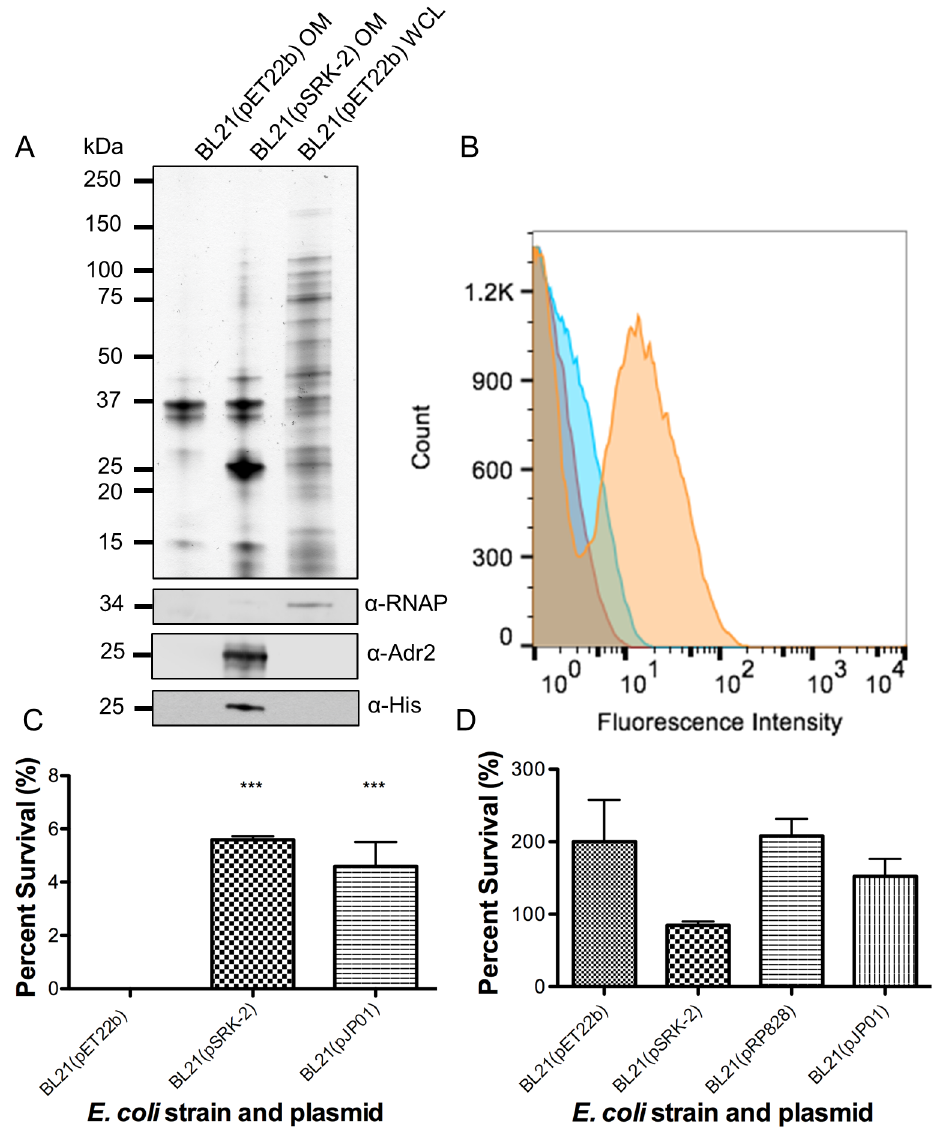
Fig 3. Expression of Adr2 at the E . coli outer-membrane is sufficient to mediate resistanceto serum- killing. (A) OM preparations or WCL from E . coli transformed with the empty vector (pET22b) or the plasmid encoding for R . conorii His 6 -tagged Adr2 are separatedby SDS-PAGE. Subsequentsilver staining demonstrates similar protein loadingand migration. Anti- E . coli RNA Polymerase alpha (RNAP) is used to demonstrate the presence of cytoplasmic contents. (B) Flow cytometry analysisrevealsthe expressionof Adr2 at the surface of E . coli . A shift in fluorescence was observedin BL21(pSRK-2 [ R . conorii Adr2]) in cultures incubatedwith both primary and secondary antibodies (orange) comparedto primary(red) or secondary(blue) alone. (C) Expression of R . conorii Adr2(pSRK-2) in E . coli (BL21) is sufficient to mediate serum-killing to normal humanserum. R . conorii Adr1(pJP01) is used as a positive control. Results are shown as the mean ± SD (P values: *** = 0.0007). (D) Serum-sensitive E . coli (pET22b) and cultures expressing Adr2 or Adr1 survive when incubatedwith heat-inactivated normal